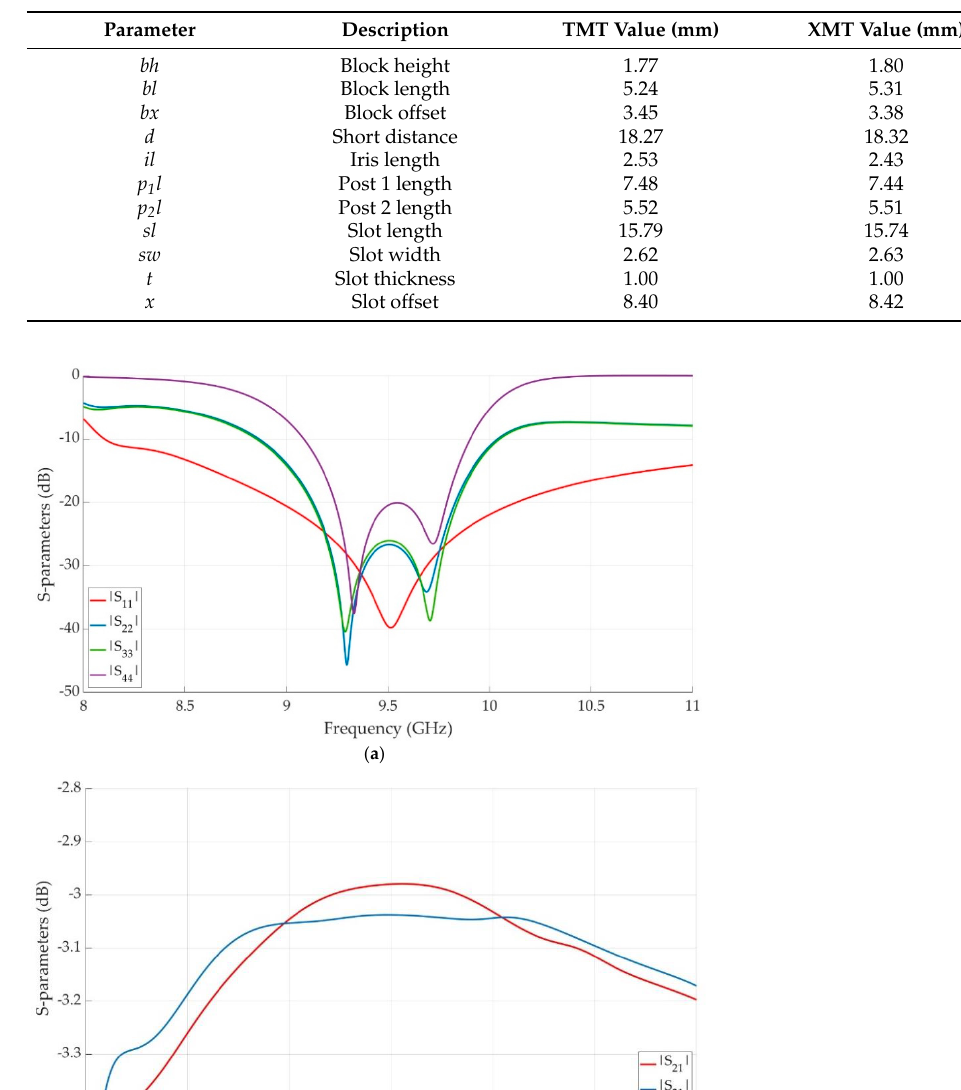
Table 4. Magic-T geometrical parameters.